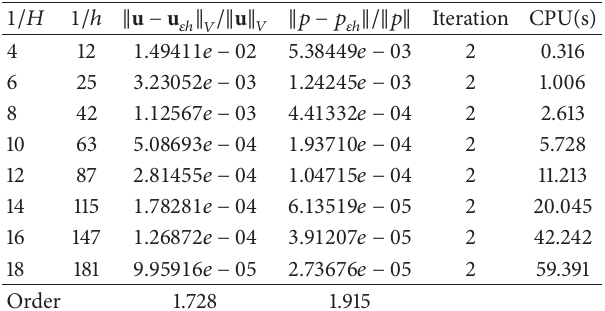
Table 5: Numerical relative error for Oseen method.